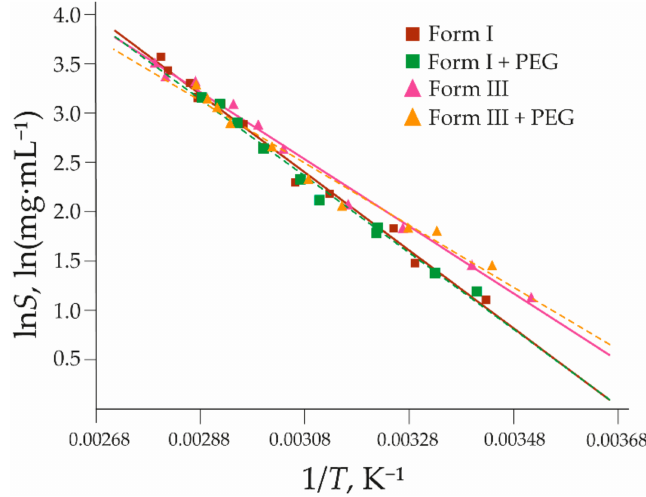
Figure 9. The solubility curves of 2,6MeOBA polymorphs I and III in pure water and 1% aqueous solution of PEG. Brown solid line—form I in pure water; Green dashed line—form I in 1% PEG solution; Magenta solid line—form III in pure water; Orange dashed line—form III in a 1% PEG solution. Triangles and squares represent the experimental data (see Supplementary Materials Tables S8 and S9); lines are calculated using Equation (1) with coefficients a and b found in the fitting using the least-squares approach, given in Table 2.